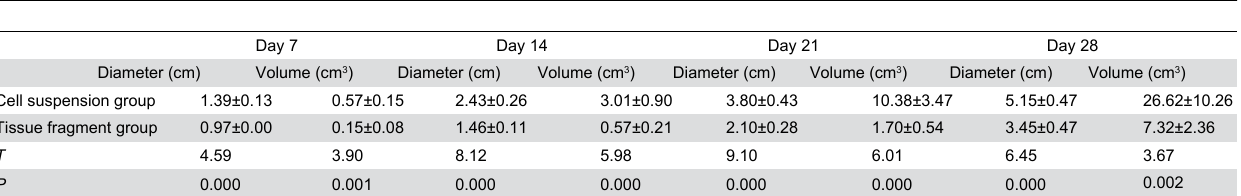
Table 2. Comparison of the tumor diameter and volume between the cell suspension group and the tissue fragment group after